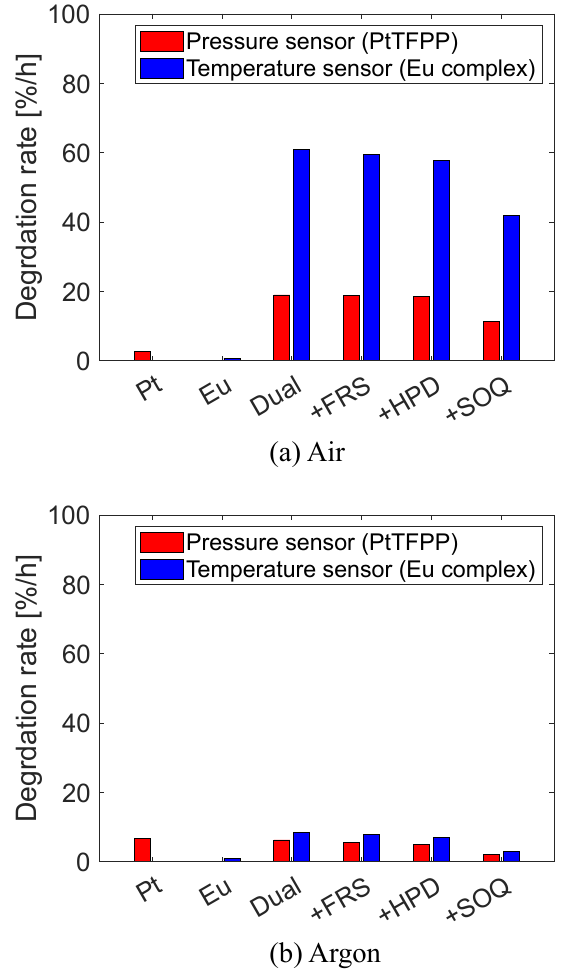
Figure 5. Degradation rates in the one-hour aging tests. Table 3. Comparison of degradation rate with previous